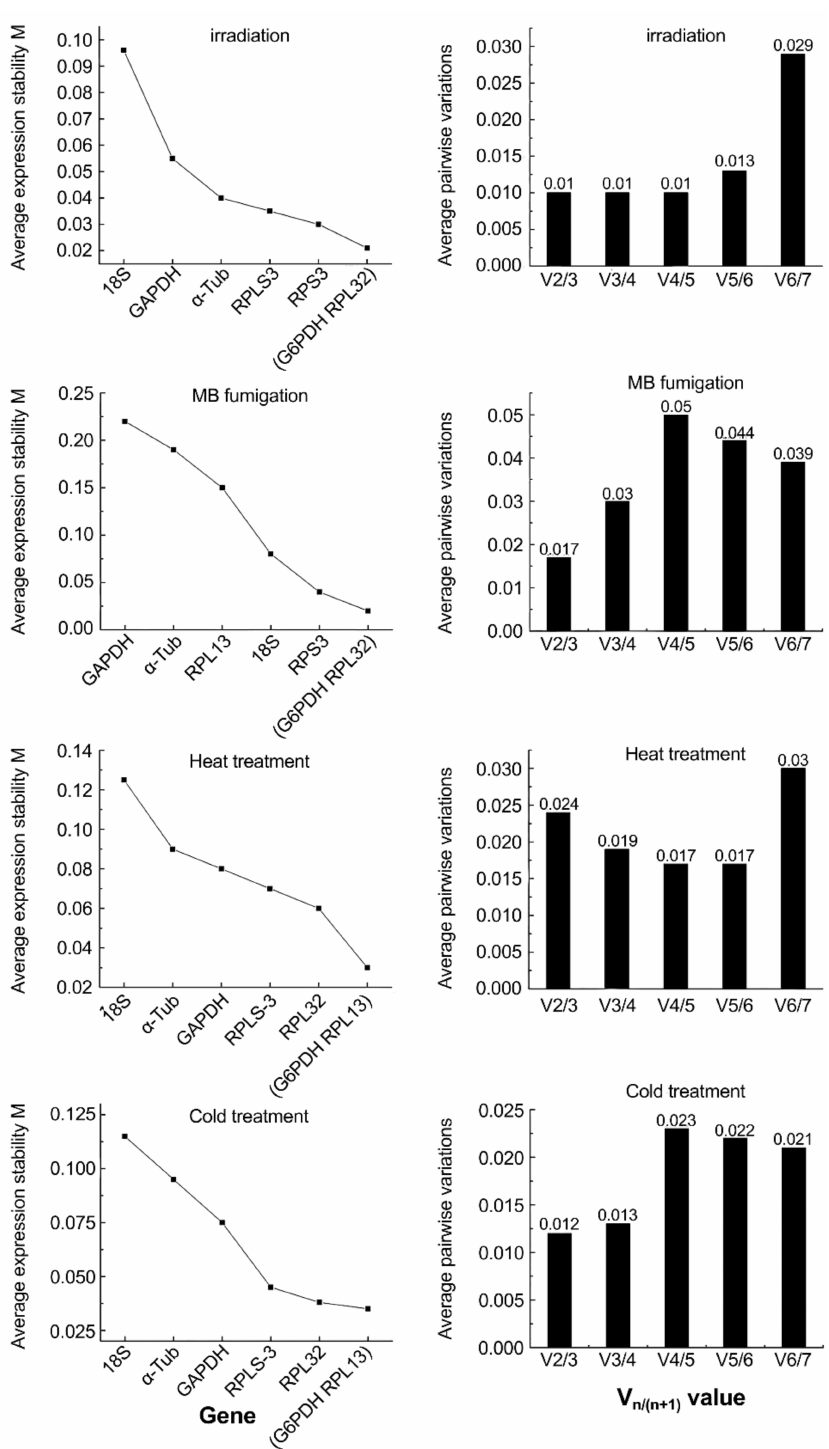
Figure 3. Analysis of expression stability and evaluation of optimal number of reference genes in B. dorsalis under different phytosanitary treatment conditions using geNorm. The left graph’s y axis is average expression stability M, and the x axis is genetic stability, increasing from left to right. The right graph’s y axis is average pairwise variations, and the x axis is V n /( n +1) values). The geNorm was used to analyze pairwise variation (using V n /( n +1) values) to deter- mine the optimum number of internal reference genes. When the V n /( n +1) value is less than 0.15, the n + 1 gene need not be introduced for correction, and the most suitable number